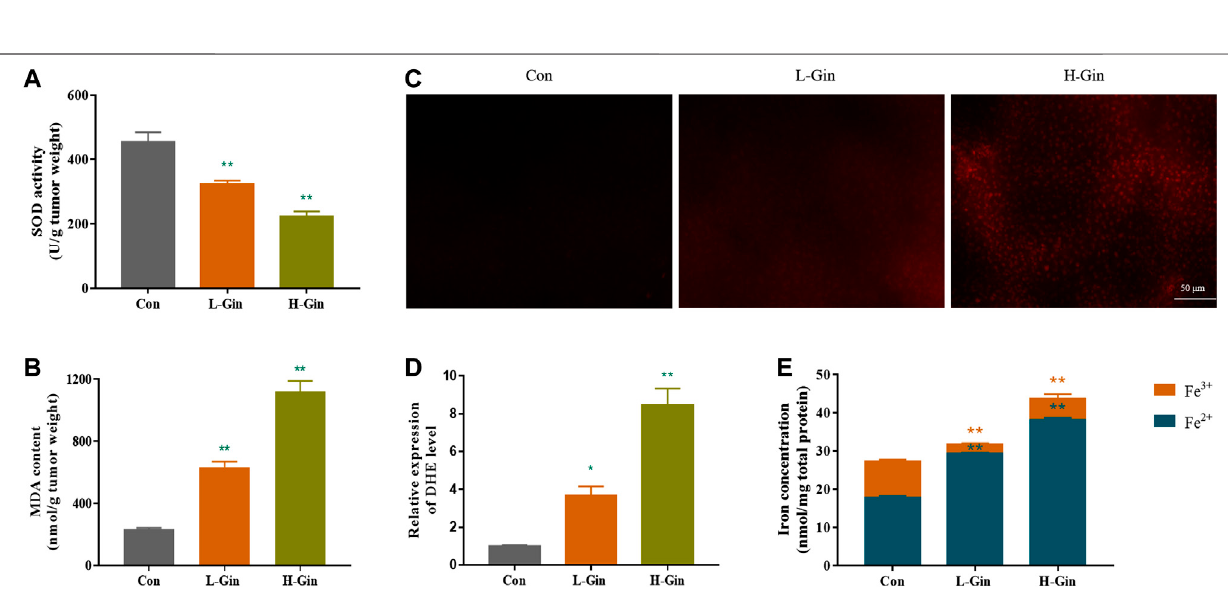
Frontiers in Pharmacology |